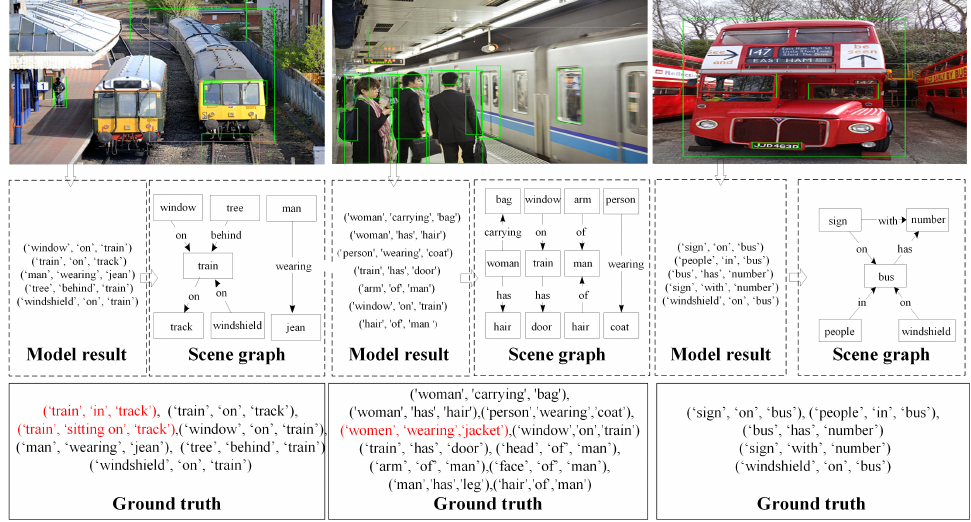
Figure 9. Qualitative examples of the performance of our model. Our model can detect most of the relationships in the depicted scenes. (The red font indicates relationship triplets that were not found by our